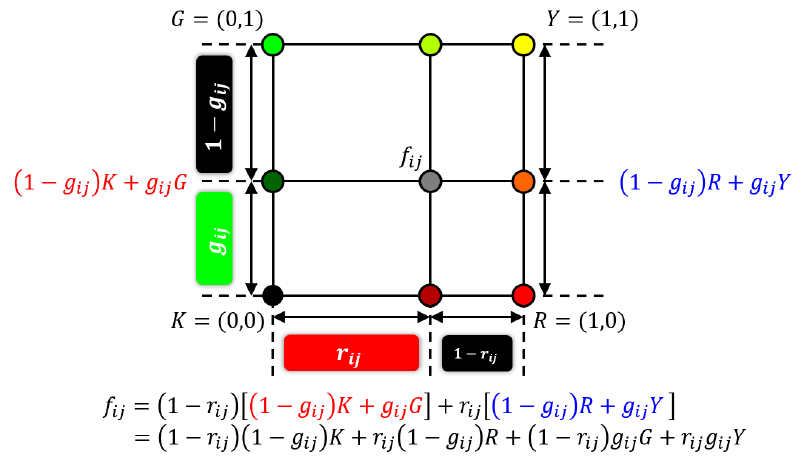
Figure 3. Two-dimensional Neugebauer